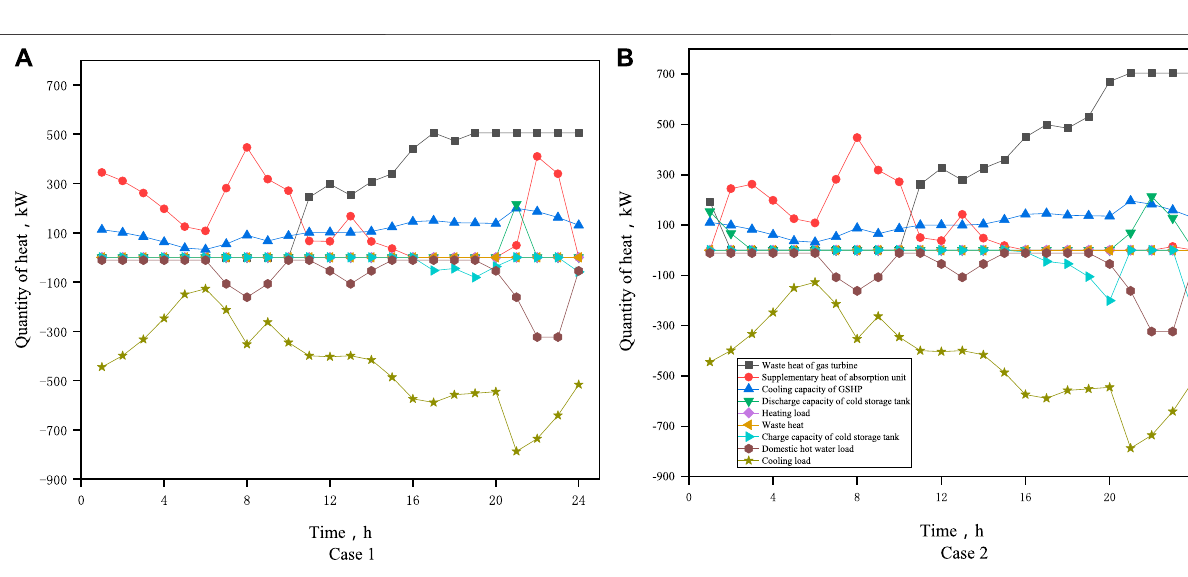
Frontiers in Energy Research |